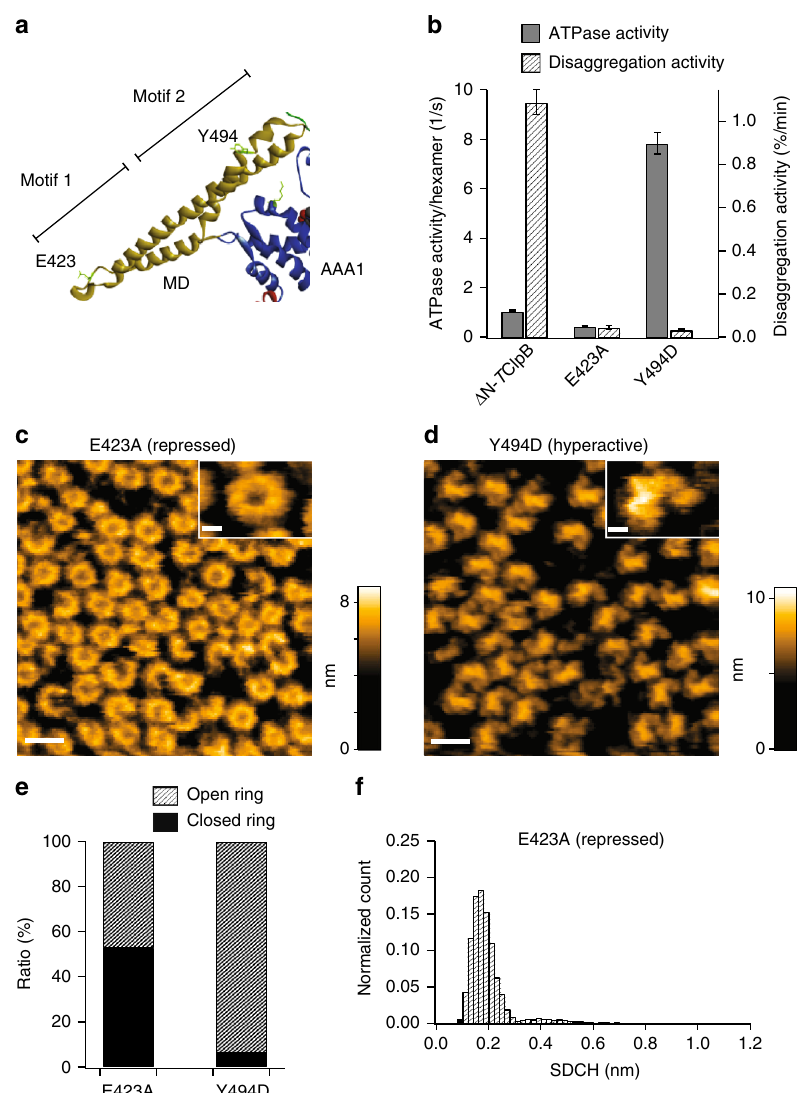
Fig. 4 Oligomeric forms and ATPase and disaggregation activities of activity mutants. a The structure of MD connecting with AAA1 of T ClpB. The positions of residues replaced for repressed (E423A) and hyperactive (Y494D) mutants are indicated. b ATPase and disaggregation activities of Δ N- T ClpB, repressed E423A and hyperactive Y494D mutants. Data are means± s.d. c , d Typical HS-AFM images of c E423A and d Y494D mutants. Scale bars, 20 nm. Z color bar, c 0 to 8.9 nm and d 0 to 10.8 nm. Insets at the upper right show magni fi ed images of respective typical oligomeric forms. Scale bars, 5 nm. e Percentages of closed (black area) and open (hatched area) forms of E423A (472 molecules) and Y494D (378 molecules). f Histogram of SDCH along hexameric rings of E423A (4810 images from 9 molecules). The major distribution is around 0.2 nm, indicating that most of the closed rings